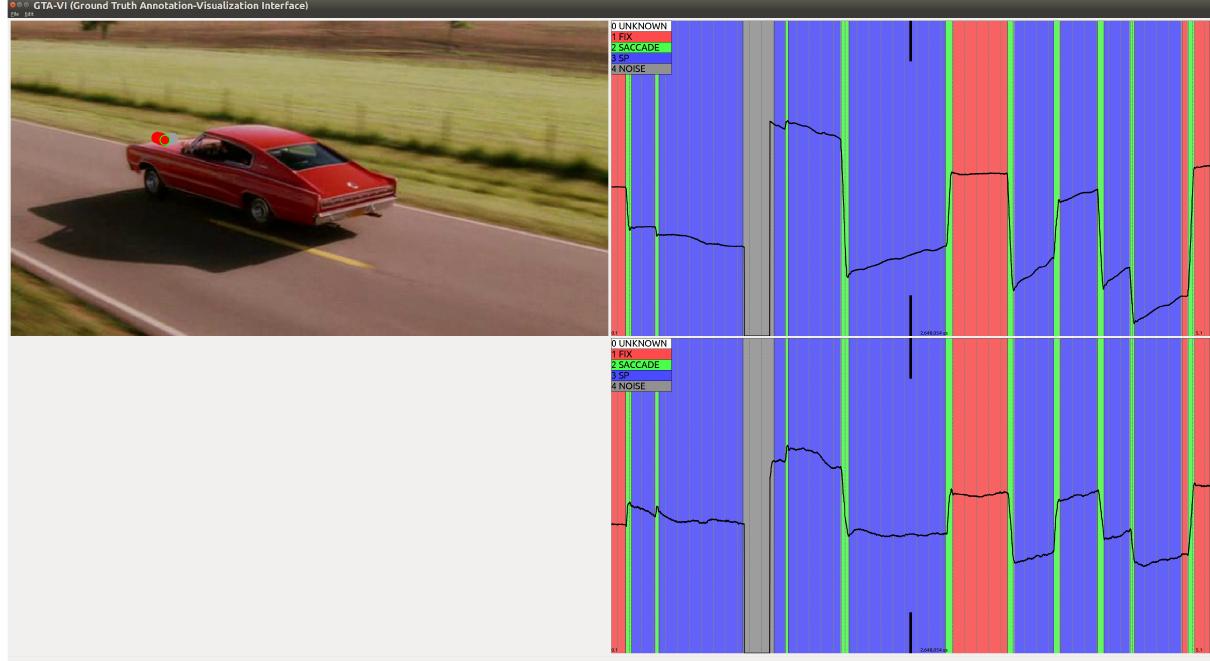
Figure 2. Example screenshot of the tool as it was used during labelling. The two panels on the right are used during the labelling procedure in order to change the borders of the colour-coded areas depending on the x and y coordinates (black lines). The still frame here (top-left panel) comes from the same video as the rightmost frame in Figure 1. For the specific participant here, most of the samples are labelled as SP (blue boxes) due to the gaze following either camera or object